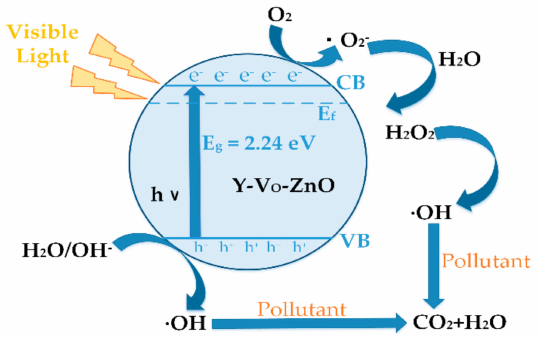
Figure 10. Photocatalytic mechanism of Y-V O -ZnO